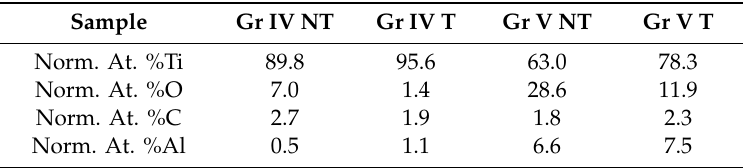
Table 6. Atomic percentages of the elements of the untreated with TiO 2 film and non-treated SLA grade IV and V samples and untreated with TiO 2 film and treated SLA grade IV and V samples. (GR IV: Titanium grade IV; GR V: Titanium grade V; T: SLA treated; NT: SLA non-treated).